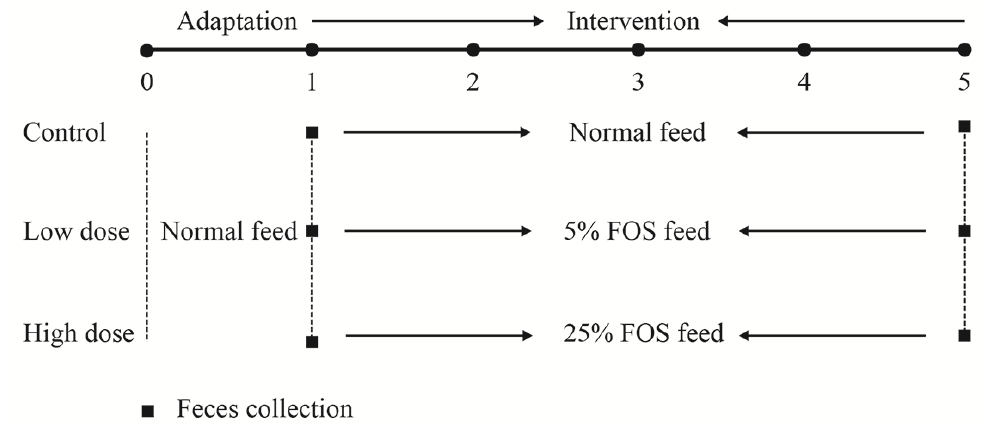
Figure 1. Experimental design. Thirty mice were randomly assigned to three groups, named the control, low-dose, and high-dose groups. During the adaptation period (first week), the mice were fed normal feed. During the intervention period, mice in the control group continued to receive normal feed, while mice in the low- and high-dose groups received the fructooligosaccharides (FOS) feed, containing 5% or 25% FOS ( w / w ), respectively. Feces were collected before and after FOS treatment on the first and fifth week.